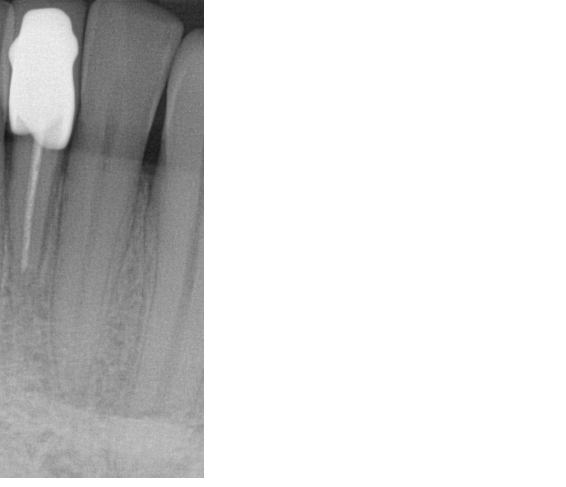
Figure 8. Radiologic image at recall shows stable marginal bone level and no apical translucencies.